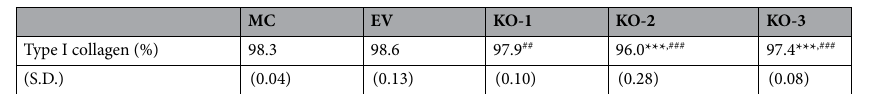
Table 1. Collagen type analysis by mass spectrometry of cell/matrix layer from controls (MC and EV), and KO clones. Percentages of type I collagen calculated by type I collagen/(type I + type III collagen). Values represent mean the percentages of type I collagen ± S.D. (n = 3) of triplicate analysis of the hydrolysates. Statistical differences were determined by Kruskal–Wallis one-way analysis of variance and means comparison with the controls by Dunnett’s method. MC MC3T3-E1, EV empty vector, KO knock-out. *** p < 0.001 between MC and KO; ## p <0.01 and ### p < 0.001 between EV and KO, respectively. We next calculated the extent of glycosylation of Hyl at six sites identified, i.e., α1 Lys-87, α1 Lys-99, α1 Lys- 174, α1 Lys-564, α2 Lys-174, and α2 Lys-219 (Table 4). When calculated as percentages of non-glycosylated-Hyl and glycosylated (G- and GG-) forms in total Hyl, the relative abundance of glycosylated Hyl at α1 Lys-87, the